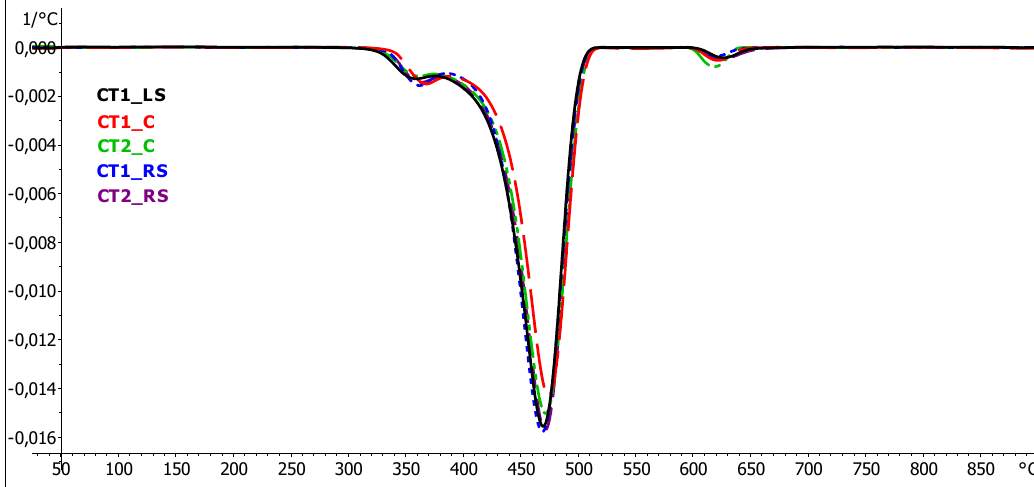
Figure 14. DTG curves of tested samples.